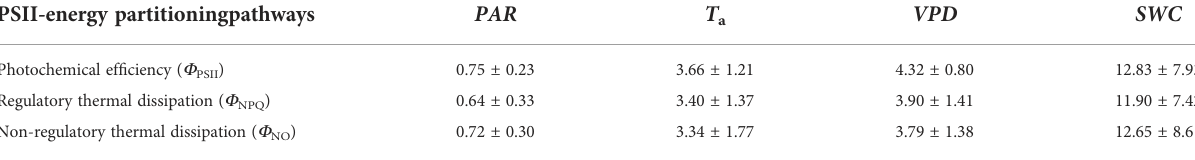
TABLE 1 Time lags between PSII-energy partitioning along the three pathways and environmental factors on a daily timescale [i.e., photosynthetically active radiation ( PAR ), air temperature ( T a ), vapor pressure de fi cit ( VPD ), and soil water content at a 0.3-m depth ( SWC )]. PSII-energy